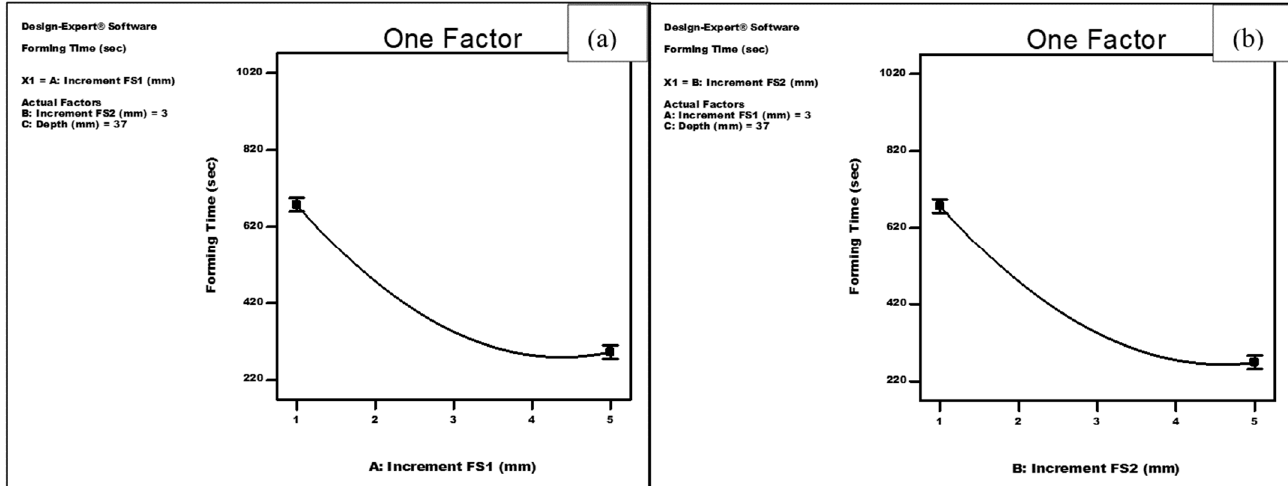
Figure 8. Effect of ( a ) increment of forming stage 1 (FS1) and ( b ) increment of forming stage 2 (FS2) on the forming time.